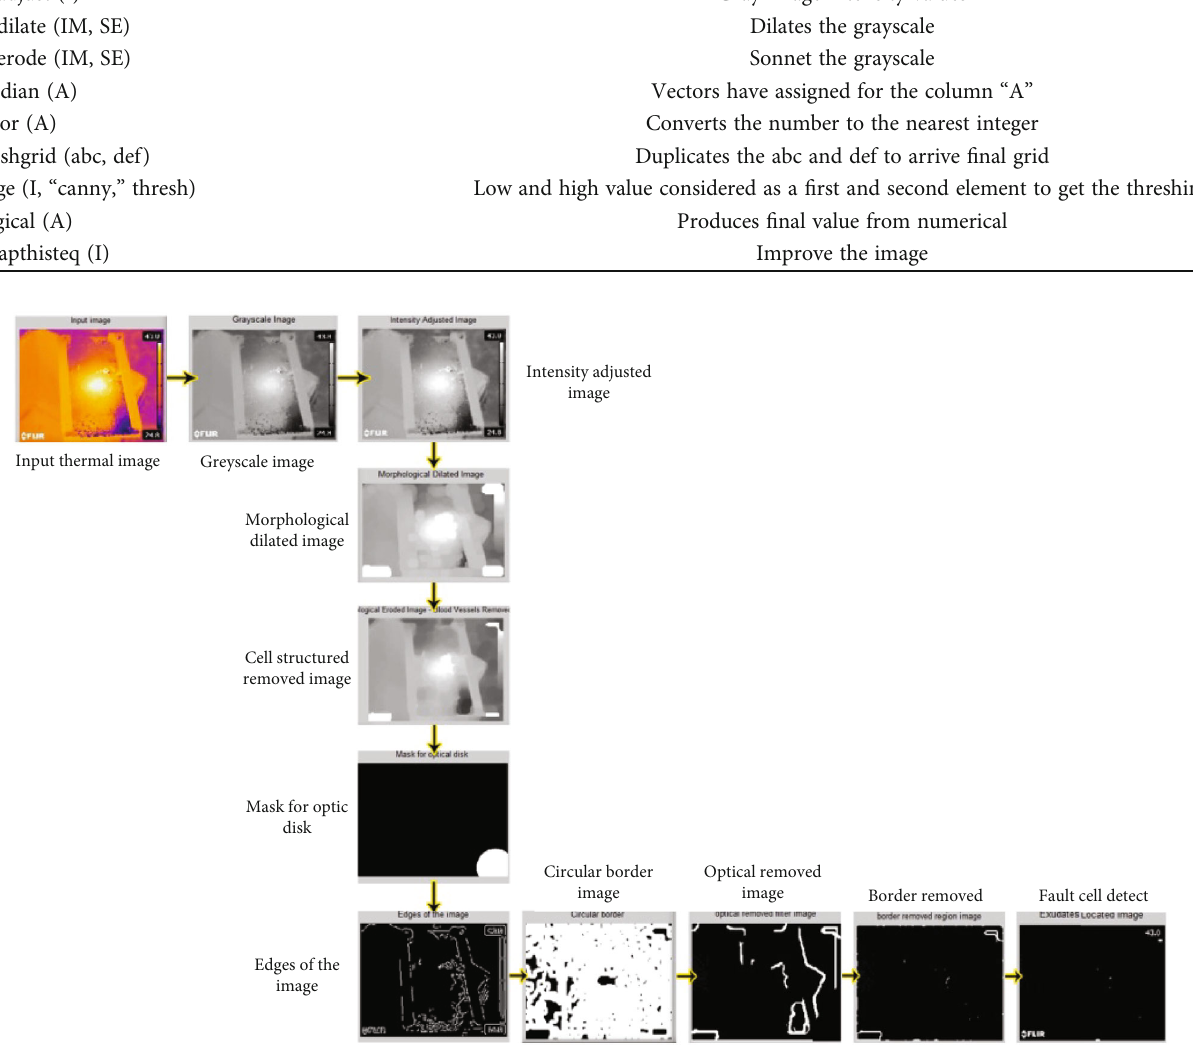
Figure 5: Thermal image